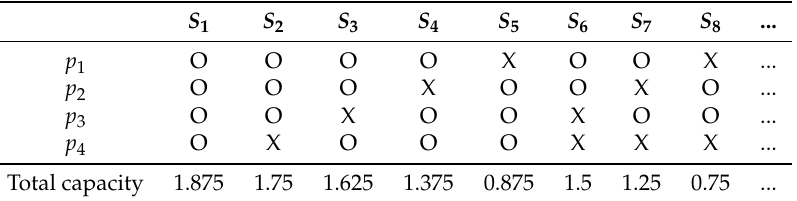
Table 6. Selecting processors for scheduling a task